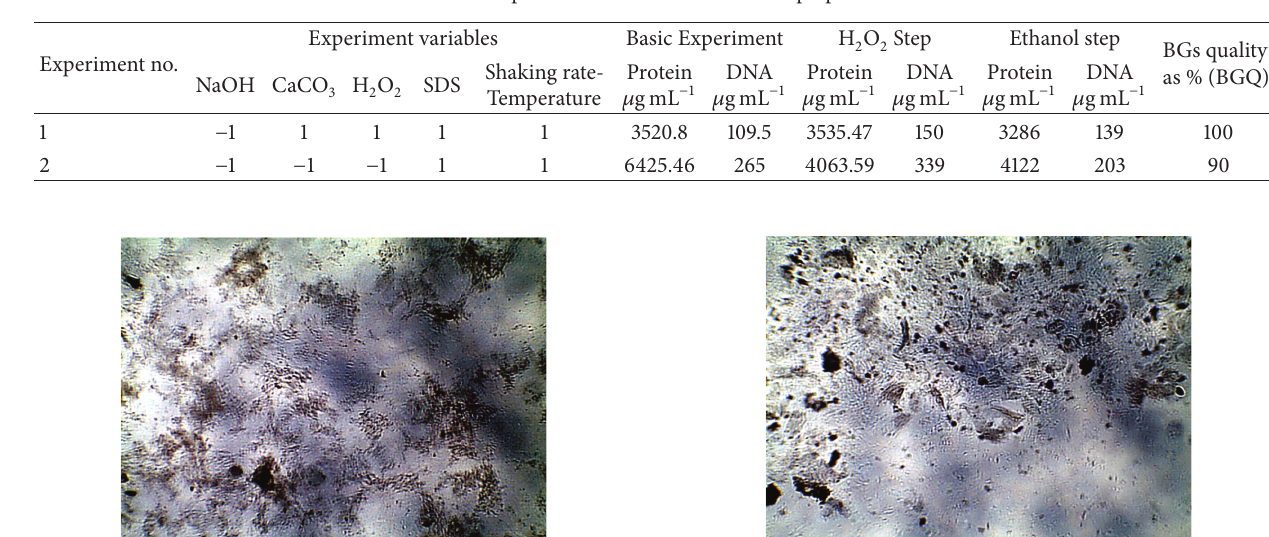
Table 1: Experiments one and two for BGs preparation.